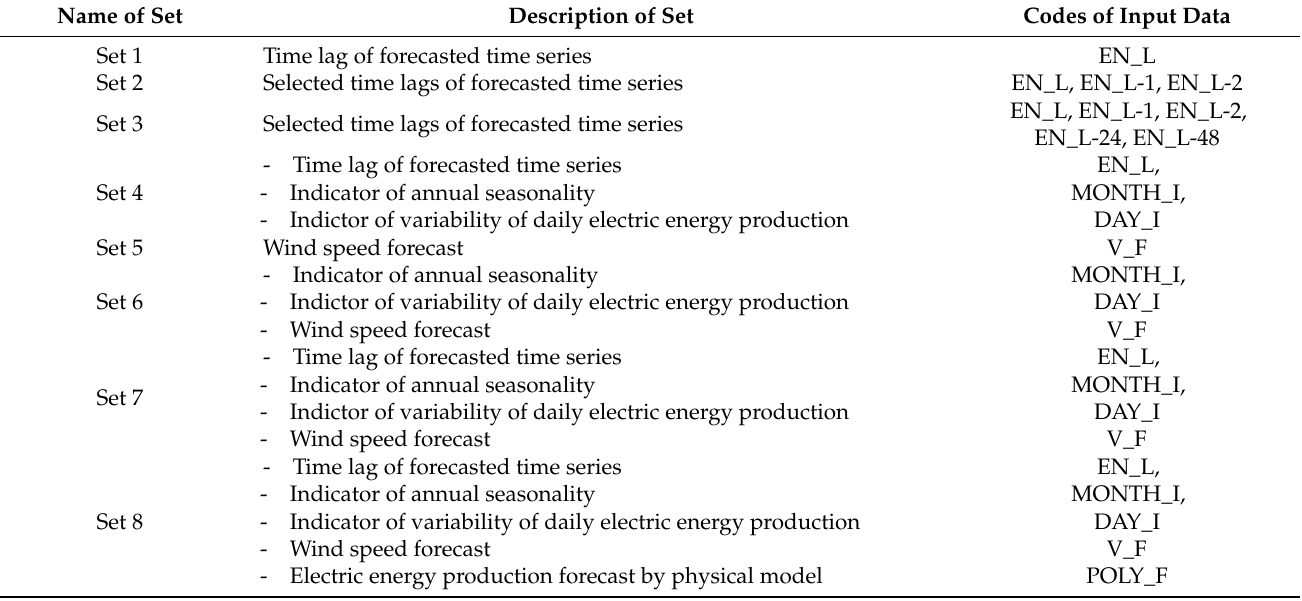
Table 4. Sets of input data selected for forecasting